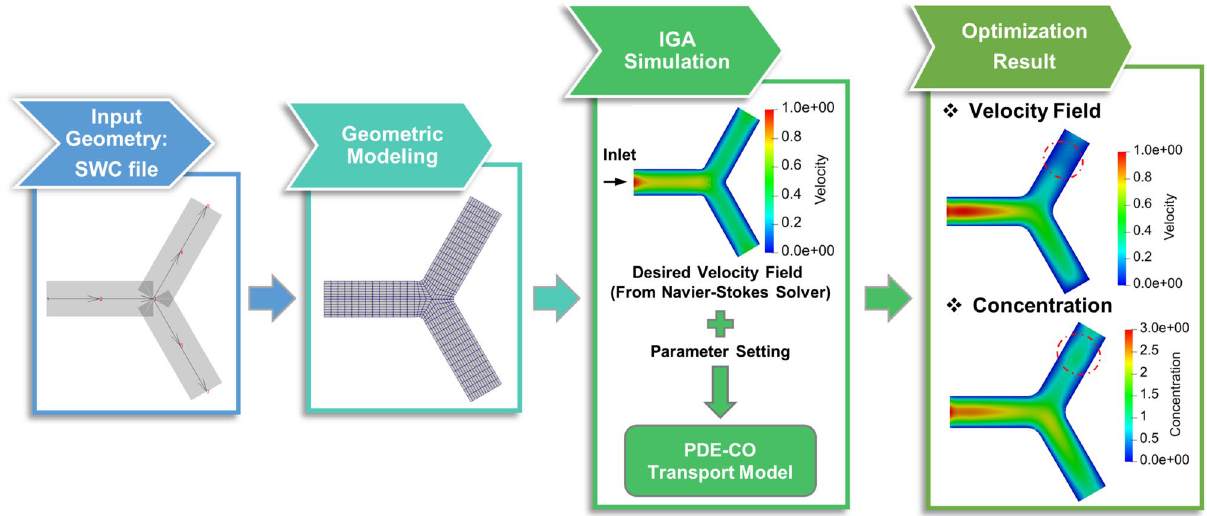
Figure 1. An overview of the material transport control simulation in a bifurcation geometry. The traffic jam is introduced by reducing MTs in the red dashed circle region. Color bars unit for velocity field: µ m/s and 2 concentration: mol/ µ m .